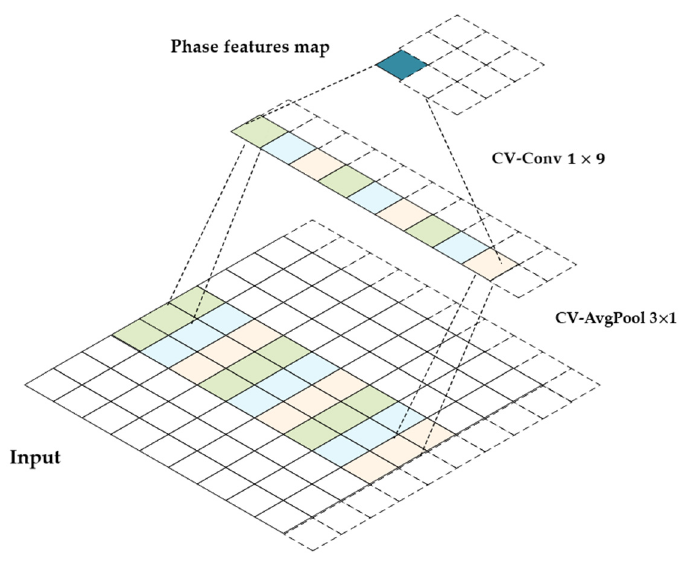
Figure 6. Phase convolution consists of cv conv 1 × 9 in the azimuth direction and cv avgpool 3 × 1 in the range direction.